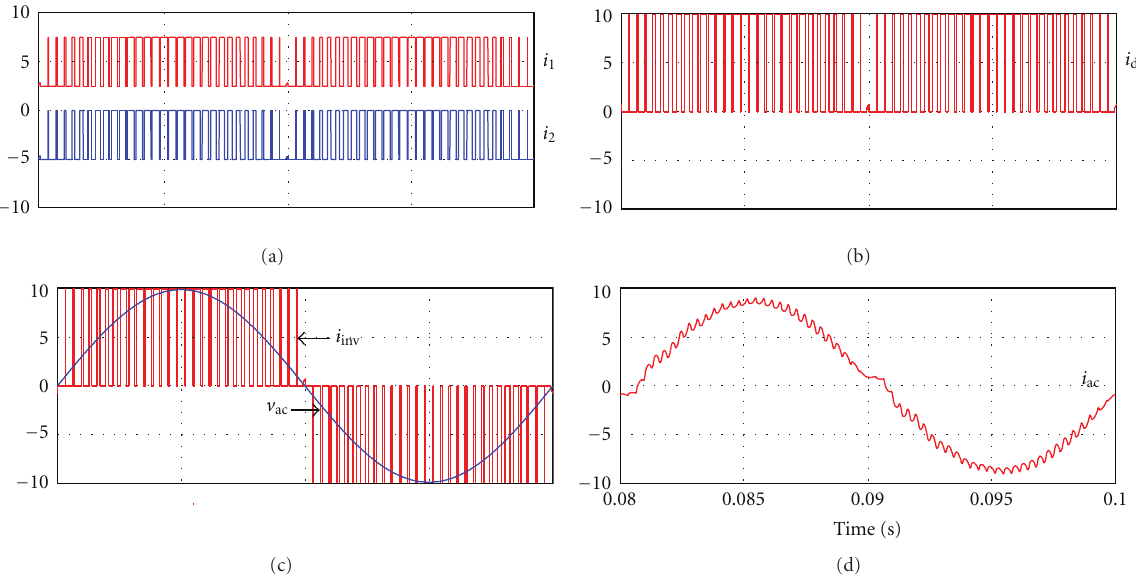
Figure 13: Operation of the system under the conditions of m pv = m wind , I pv = I wind , f line = 50Hz and f sw = 3kHz (top to bottom) i 1 , i 2 , i dc , v i i inv , ac , and ac